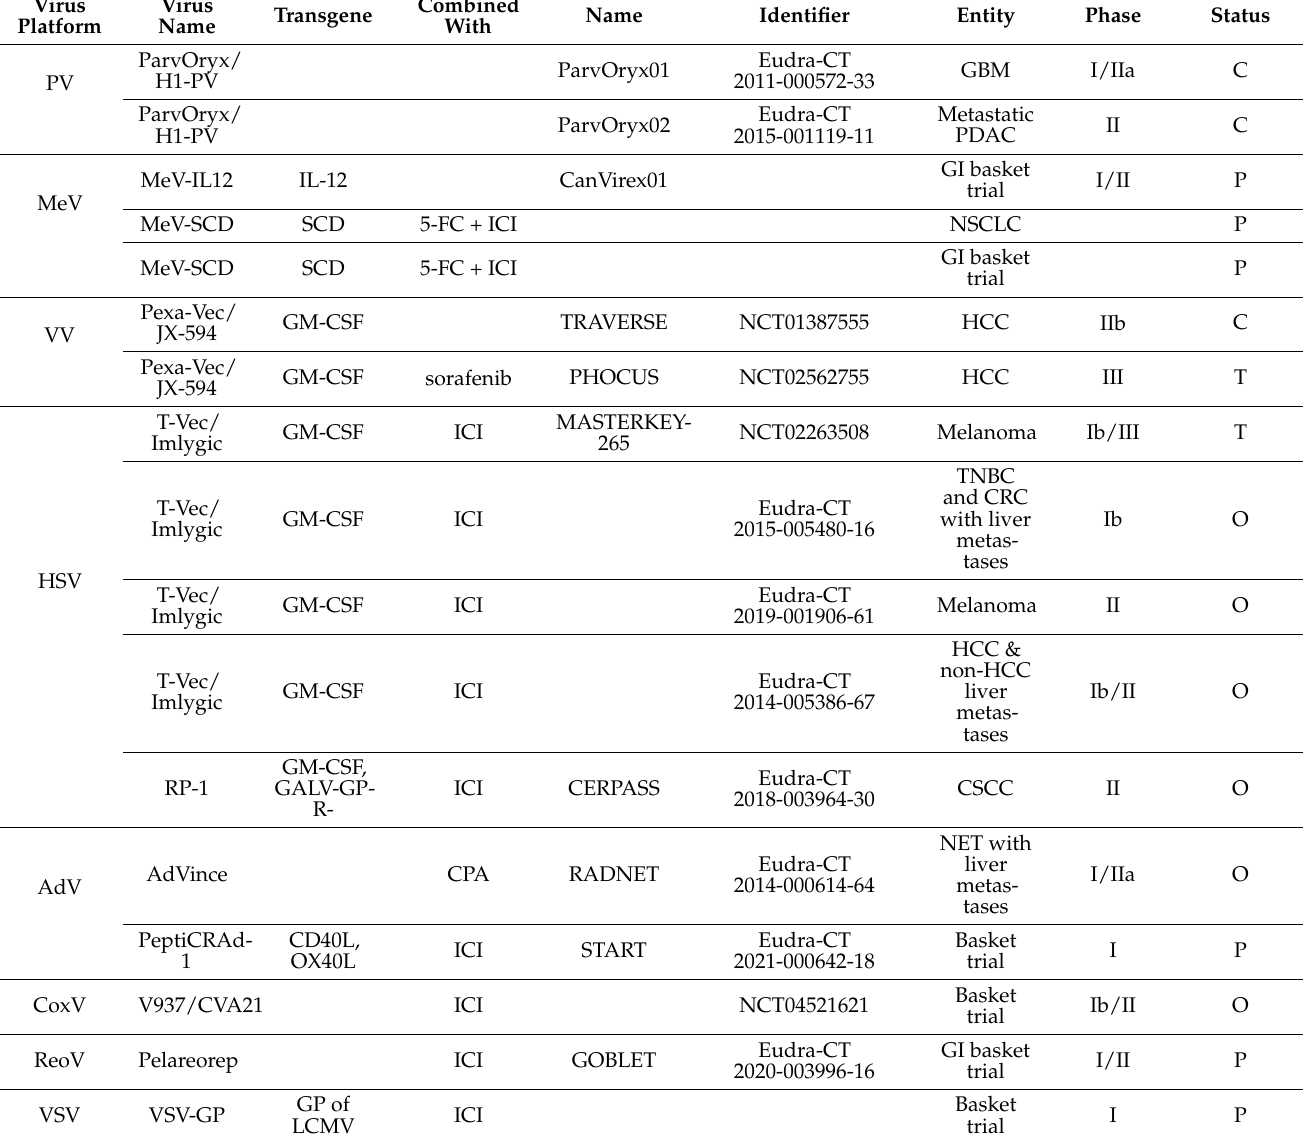
Table 2. Recent virotherapy trials initiated by or involving the authors of this article. Pexa-Vec = Pexastimogene devacirepvec; T-Vec = Talimogene laherparepvec; SCD = super cytosine deaminase; GALV-GP-R - = gibbon ape leukemia virus glycoprotein; ICI = immune checkpoint inhibition; CPA = cyclophosphamide; GBM = glioblastoma multiforme; PDAC = pancreatic ductal adenocarcinoma; GI = gastrointestinal; NSCLC = non-small cell lung cancer; HCC = hepatocellular carcinoma; TNBC = triple- negative breast cancer; CRC = colorectal carcinoma; CSCC = Cutaneous Squamous Cell Carcinoma; NET = neuroendocrine tumors; C = completed; P = planned; T = terminated; O =